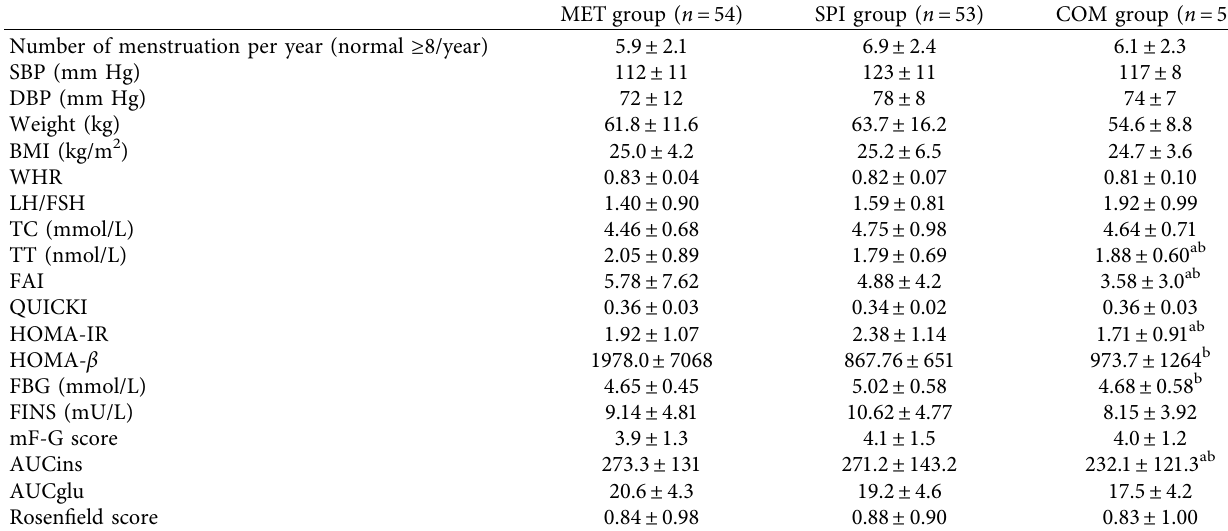
Table 3: Comparison of the outcomes among the three groups after 12 weeks of treatment.